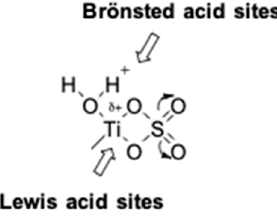
Figure 3. Schematic representation of the Brönsted and Lewis acid sites in the sulfated titania. Table 2. Conversion of 2-propanol and oleic acid esterification on sulfated titania. Catalyst